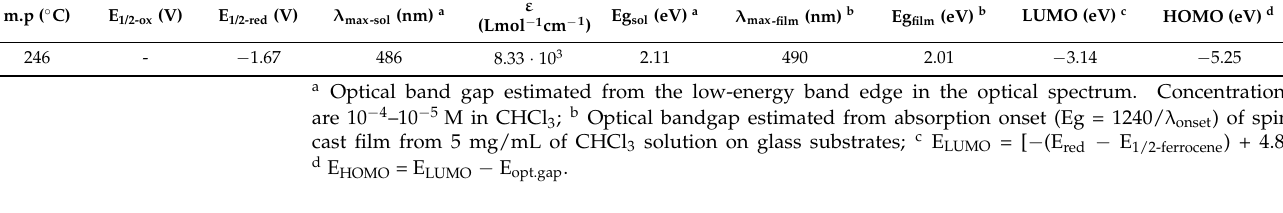
Table 1. Thermal, electrochemical and spectroscopic characterization of [5]helicenebenzoquinone 1 .